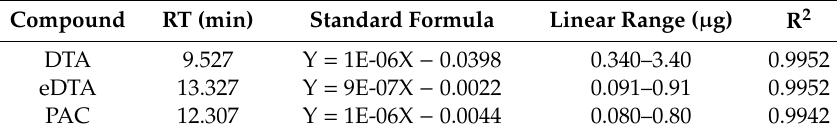
Table 4. Regression equations and linear ranges of three triterpenoids.